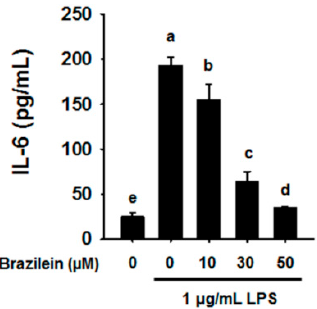
Figure 3. Brazilein suppressed IL-6 cytokine production in LPS-induced Raw264.7. Cells were pretreated with 10, 30, or 50 μ M brazilein for 1 h, treated with 1 μ g/mL LPS, and incubated for a further 24 h. The production of IL-6 cytokine was quantified using a specific antibody-coated ELISA kit. DMSO was used as a vehicle. The data are expressed as mean ± standard deviations (SD), ( n = 3). Values with different letters are significantly different, p < 0.05.